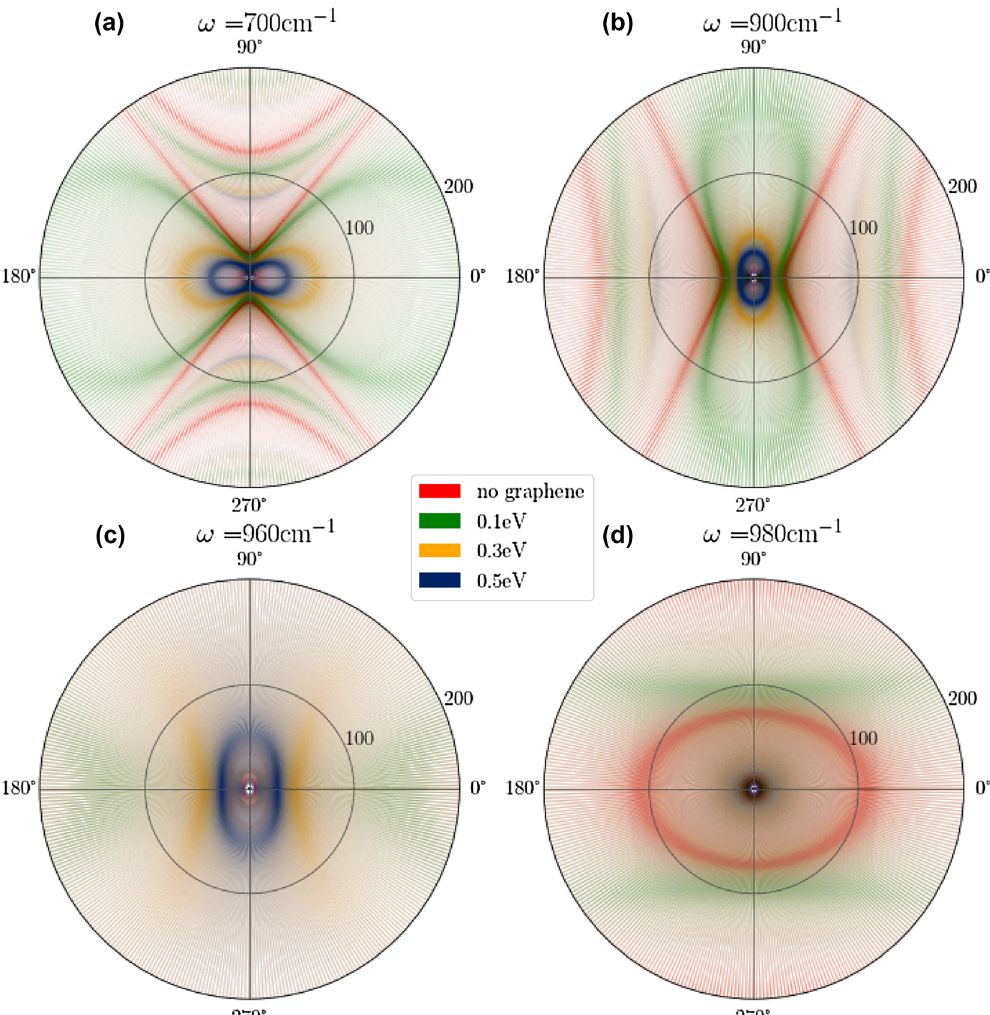
Figure 3: Polar plots of HPPP modes in 50 nm thin α -MoO 3 and graphene heterostructure as a function of graphene ’ s chemical potential (0.1, 0.3,0.5eV):HPPPfundamentaland fi rst-ordermodesarerepresentedbyimaginarypartofFresnel ’ sre fl ectioncoef fi cientfor p -polarizedlight. Radialandazimuthaldirectionscorrespondtomodeindex( k ρ / k 0 )and ϕ ,respectively.Effectofgraphene ’ schemicalpotentialonHPPPmodes is demonstrated by green, orange and blue color for μ = 0.1, 0.3, and 0.5 eV, respectively. The fringes at the edges of the polar plots are the artefact of the scatter type plotting